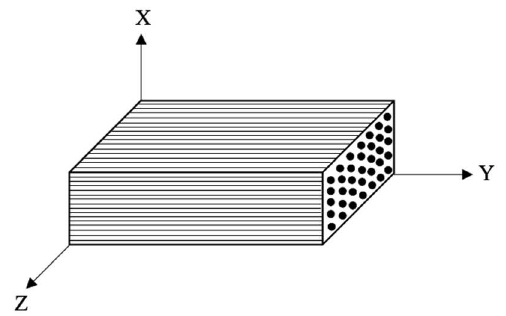
Figure 6. PSB Axis Legend. Table 1. Materials used for the preparation of the samples.